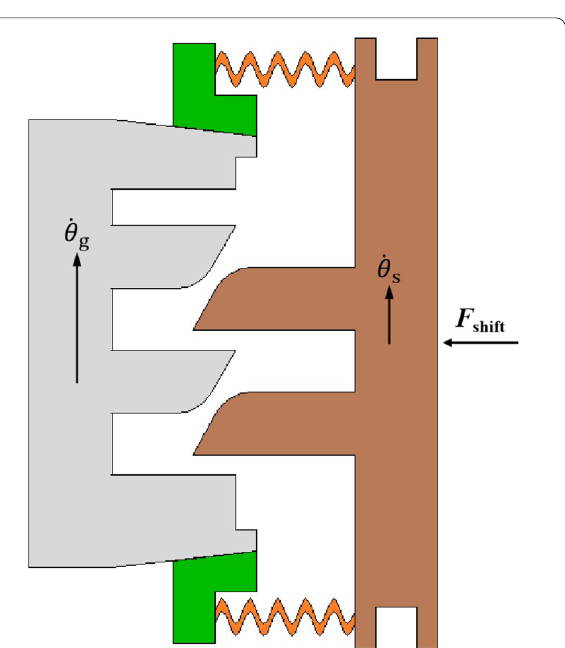
Figure 16 Schematic diagram of the turning teeth after the sleeve teeth and the friction cone ring teeth contacting